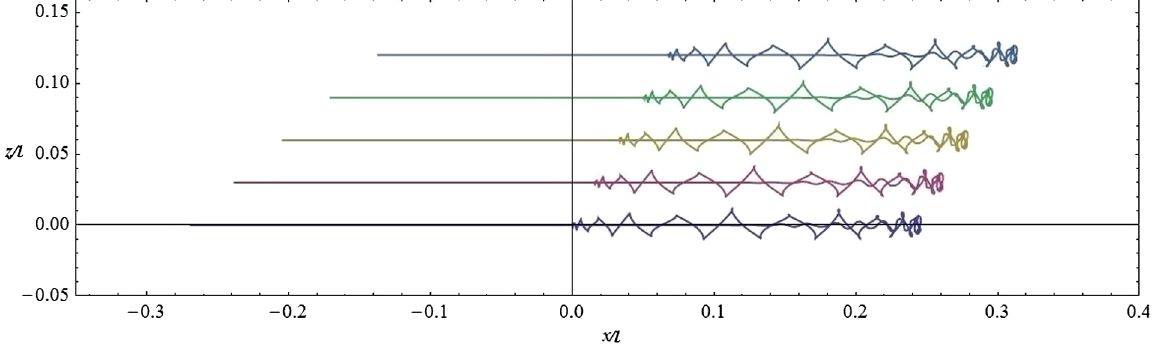
0 , 0.25, 0.5, 0.75, 1 under conditions as in Fig. 7. M ¼